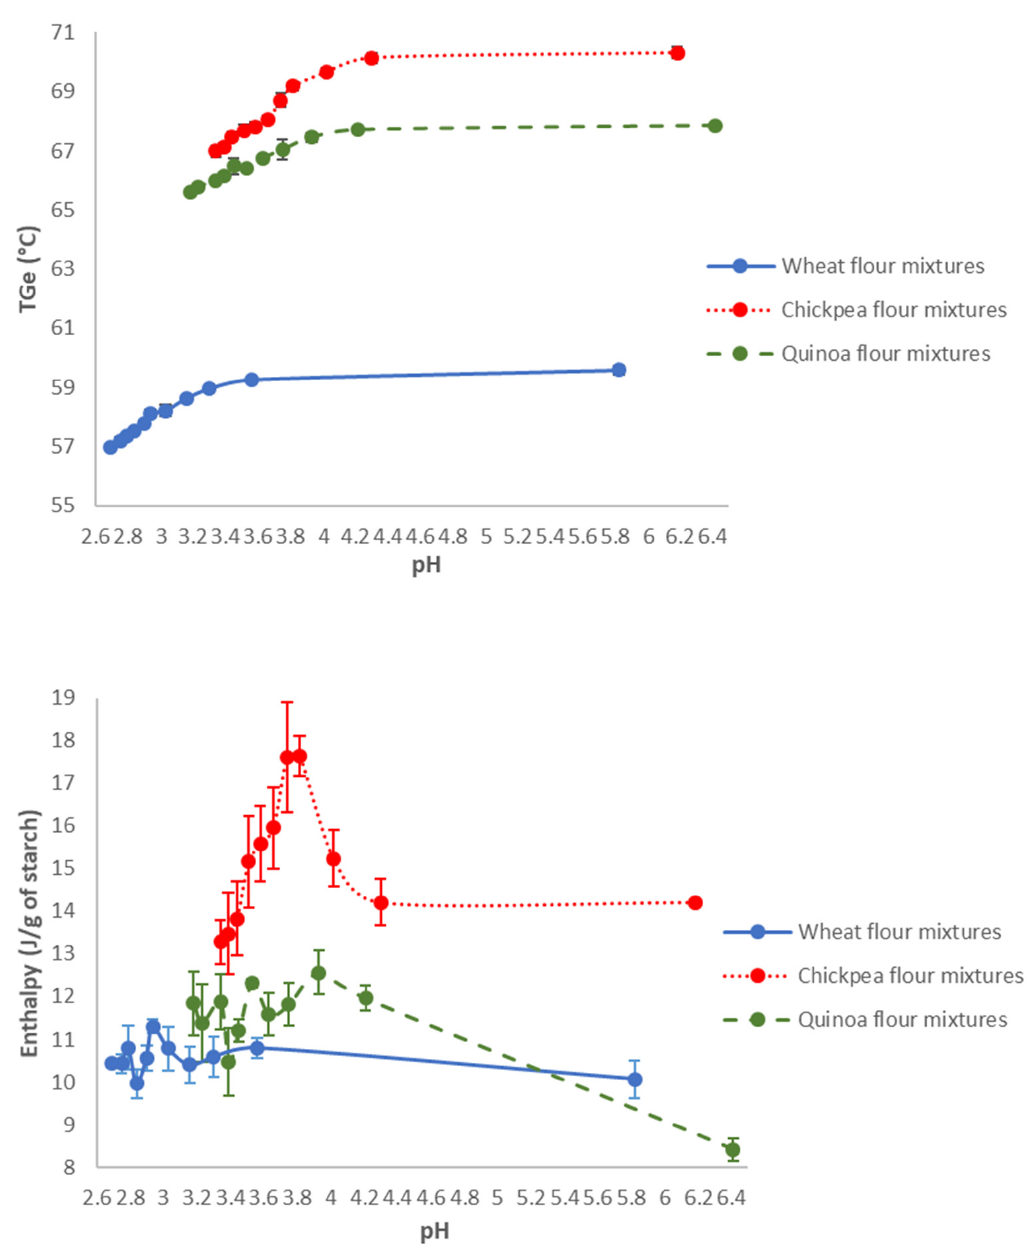
Figure 2. Gelatinization temperatures and enthalpies of standard mixtures as a function of pH. In order to know the penetration rate of the plasticizer (water + acetic acid) into the starch granule, the curves of cumulative enthalpies were calculated and reported as a function of temperature. The partial gelatinization enthalpy curves for the three starches studied are shown in Figure 3. This study made it possible to observe the kinetics of loss of the ordered structure of starch at a temperature between 45 and 80 ◦